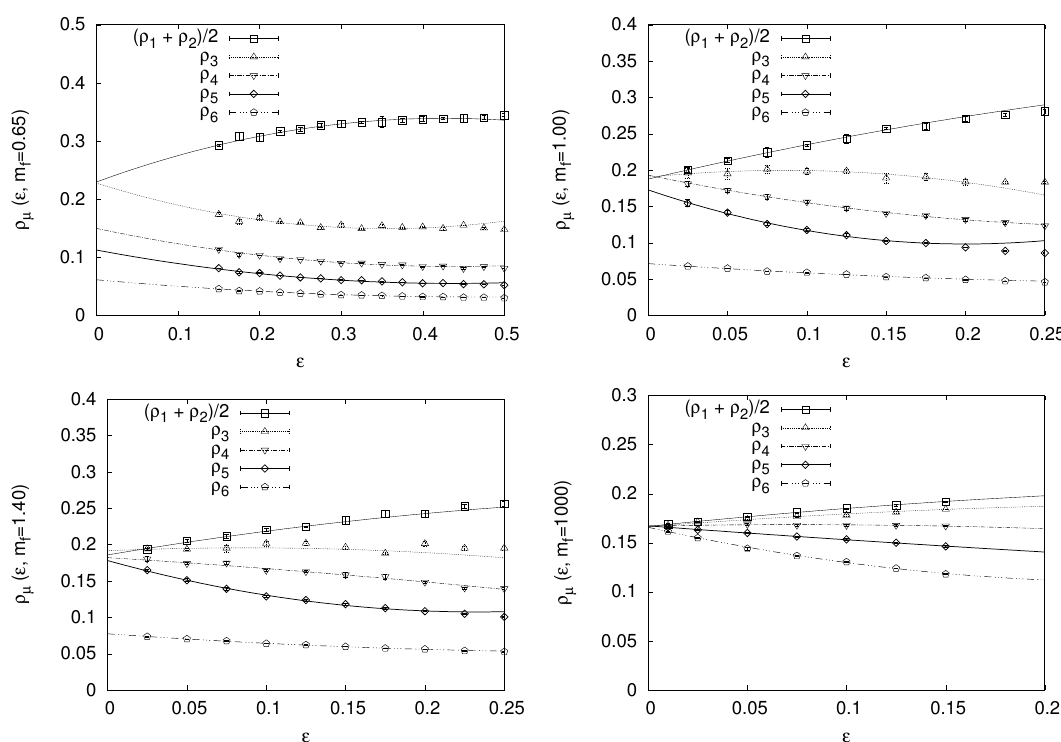
Figure 4 . The ratios (cid:26) (cid:22) ( "; m f ) de(cid:12)ned by (4.1) are plotted against " for the deformed model with m f = 0 : 65 (Top-Left), m f = 1 : 0 (Top-Right), m f = 1 : 4 (Bottom-Left) and m f = 1000 (Bottom- Right). An average is taken for (cid:26) 1 and (cid:26) 2 according to the treatment in (cid:12)gure 3. The lines represent (cid:12)ts to the quadratic form a + b" + c" 2